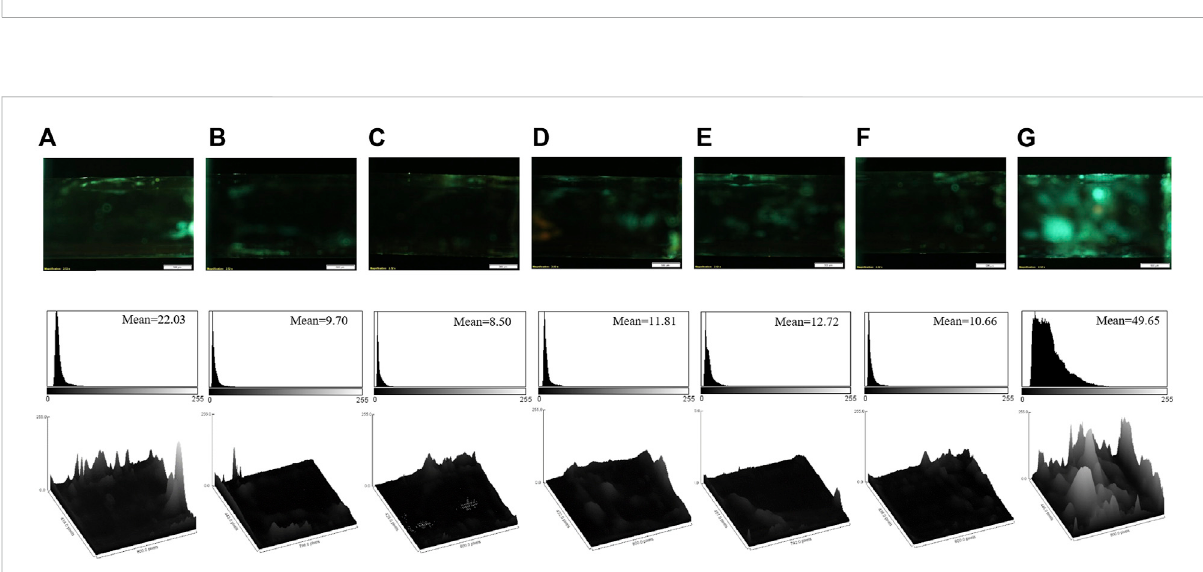
The fl uorescence images, correspondingmeanbrightness values,and surfaceplots oftheaptasensor inthepresence ofthedifferentdrugs: (A) diazepam; (B) lorazepam; (C) methadone; (D) morphine; (E) tramadol; (F) ibuprofen; (G) cocaine(the fi nalconcentrationofeachcompoundis8 μ M). Scale bar: 500 μ